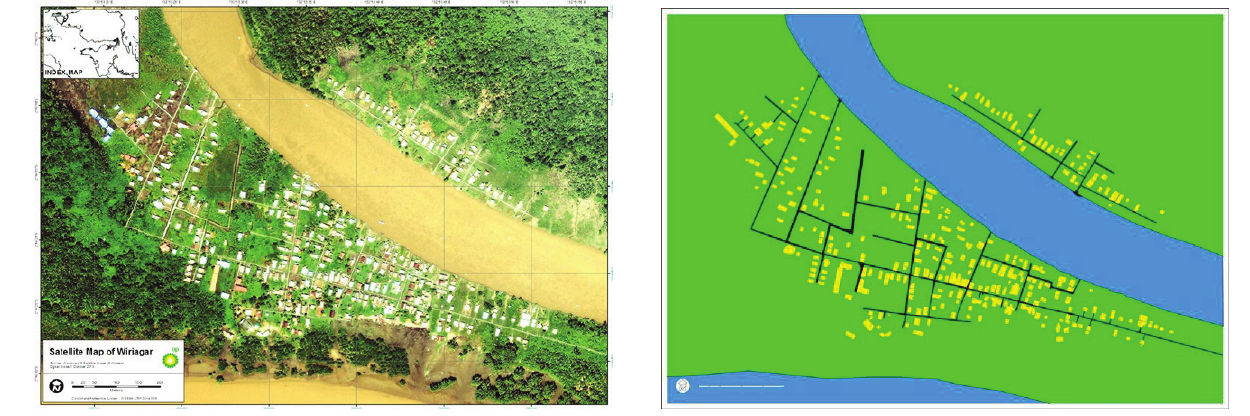
Figure 1. Site MAP Figure 2. Green Area in Weriagar